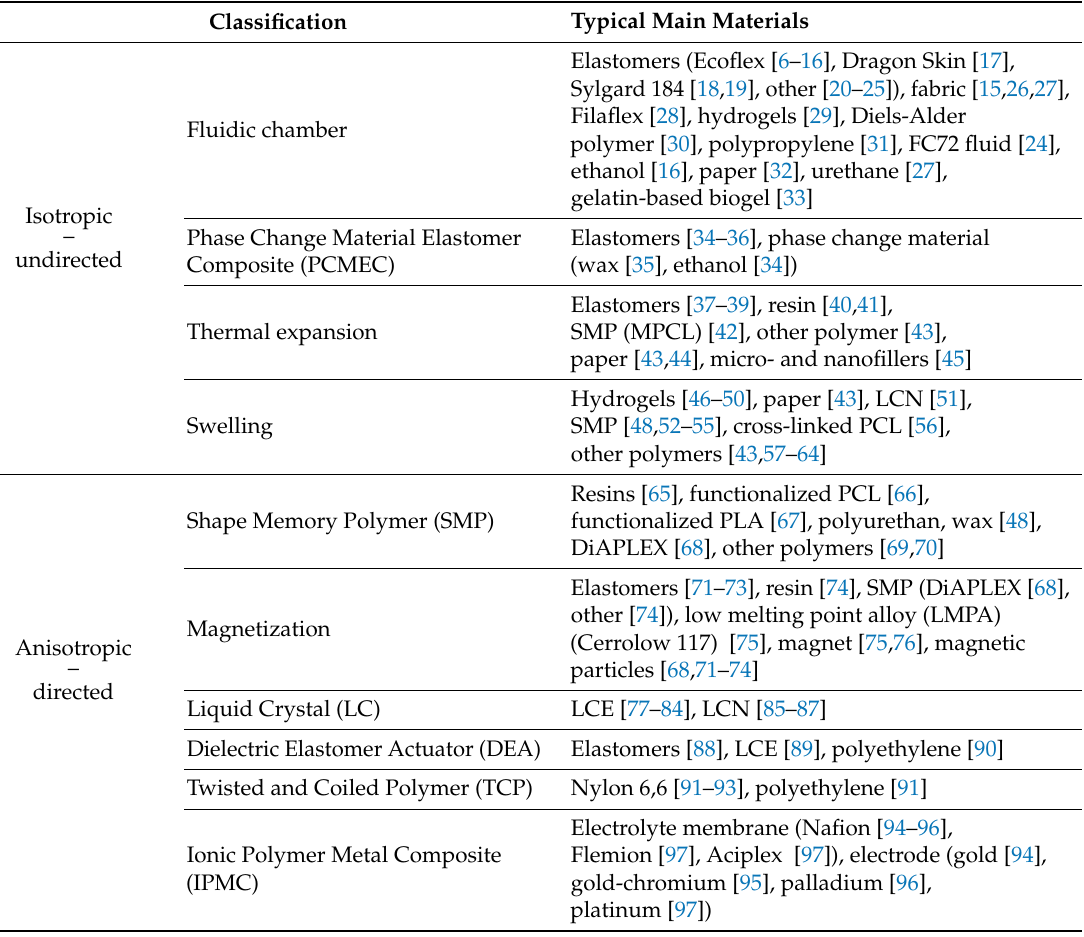
Table 1. Stimuli-responsive transducers for soft robotics, classified as a function of their intrinsic asymmetry: isotropic transducers will deform isotropically when subjected to a stimulus, contrary to anisotropic transducers. Typical materials used are also